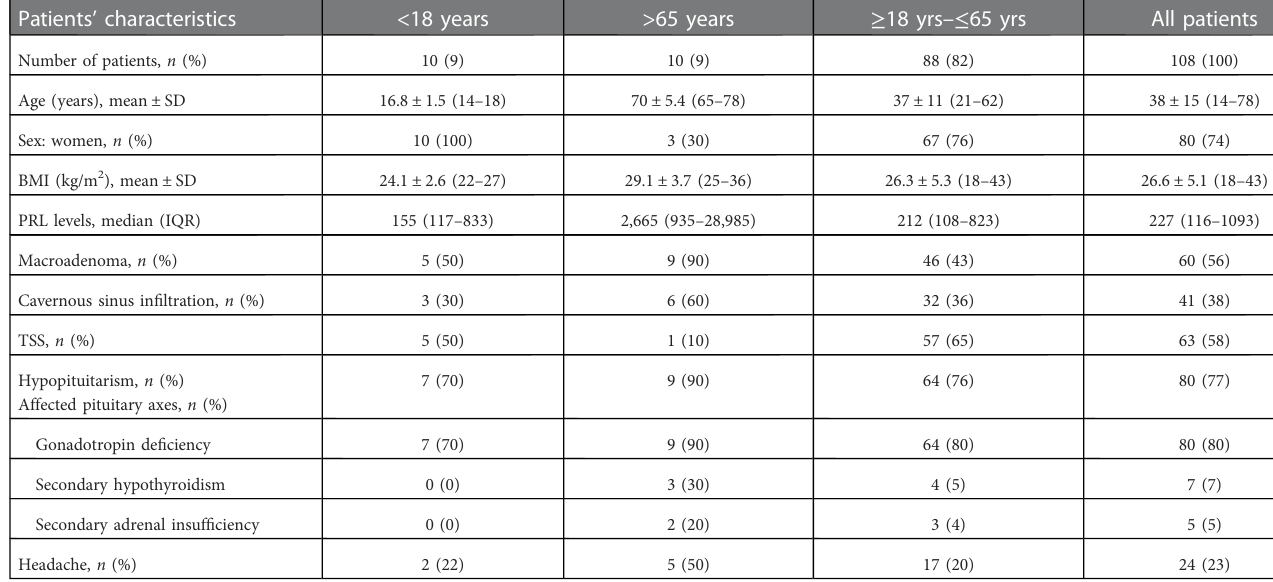
TABLE 1 Patient characteristics at